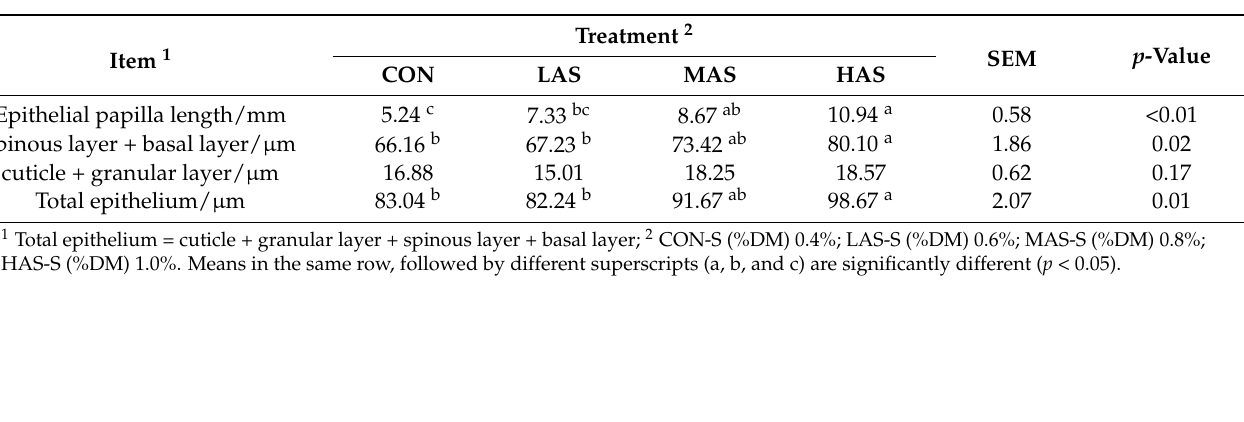
Figure 6. Present of Desulfovibrio in rumen samples. CON-S (%DM) 0.4%; LAS-S (%DM) 0.6%; MAS-S (%DM) 0.8%; HAS-S (%DM) 1.0%. Asterisks mean significant difference between CON and HAS groups.